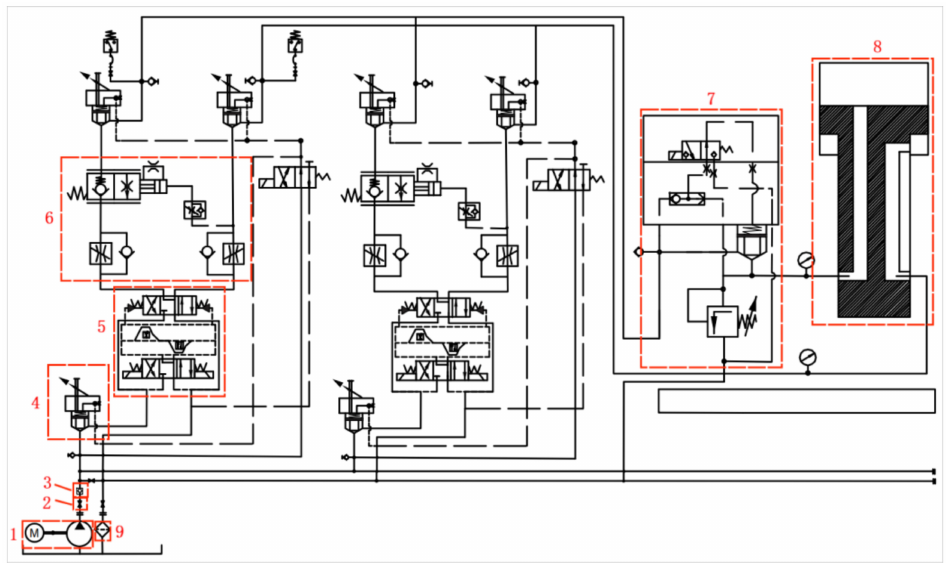
Figure 2. Schematic diagram of the wing lifting and lowering hydraulic system. 1. Hydraulic pump; 2. globe valve; 3. check valve; 4. cartridge valve; 5. electro-hydraulic re-versing valve; 6. balance valve group; 7. safety globe valve group; 8. hydraulic cylinder; 9. oil return